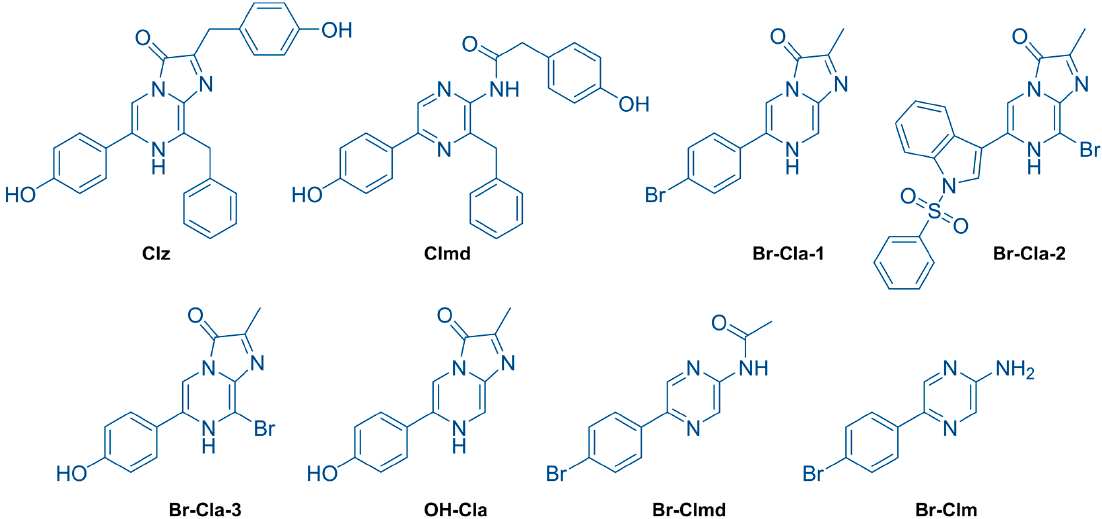
Figure 1. Structures of naturally occurring Coelenterazine ( Clz ) and Coelenteramide ( Clmd ), and their synthetic derivatives Br ‐ Cla ‐ 1/2/3 , OH ‐ Cla , Br ‐ Clmd , and Br ‐ Clm